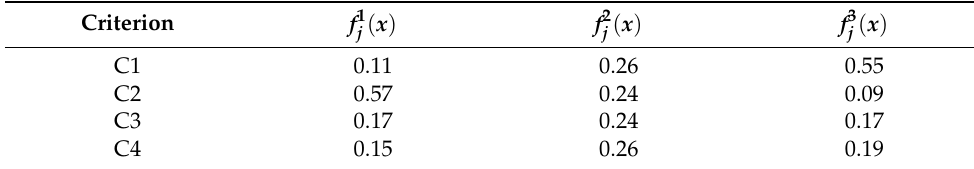
Table 10. Weight values for each criterion.